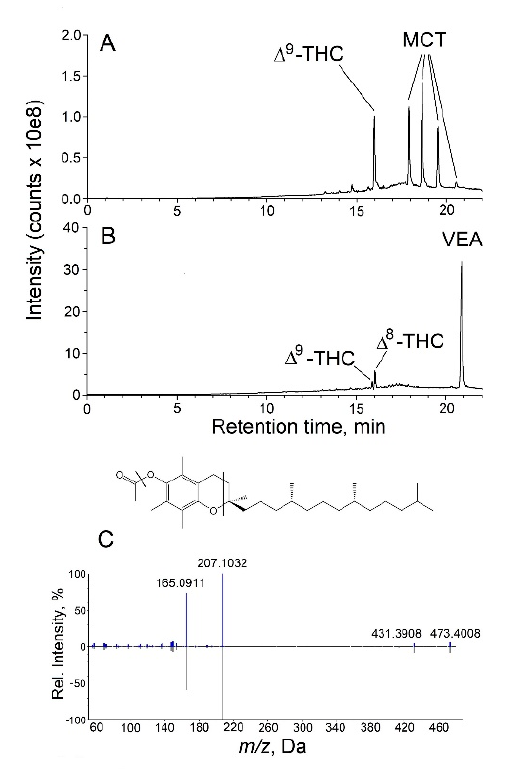
Figure 2. Untargeted analysis of vaporizer fluids using LC-HRMS / MS. Shown in panel ( A ) is the TIC chromatogram from the analysis of a THC-containing vaporizer fluid in which MCT was identified. In panel ( B ), the TIC chromatogram from the analysis of a vaporizer fluid is shown in which ∆ 8 -THC, ∆ 9 -THC and VEA were identified. In panel ( C ), the high-resolution MS / MS spectrum recorded for VEA in the vaporizer fluid is shown in comparison with that of a VEA standard, with points of fragmentation in the VEA structure as indicated.